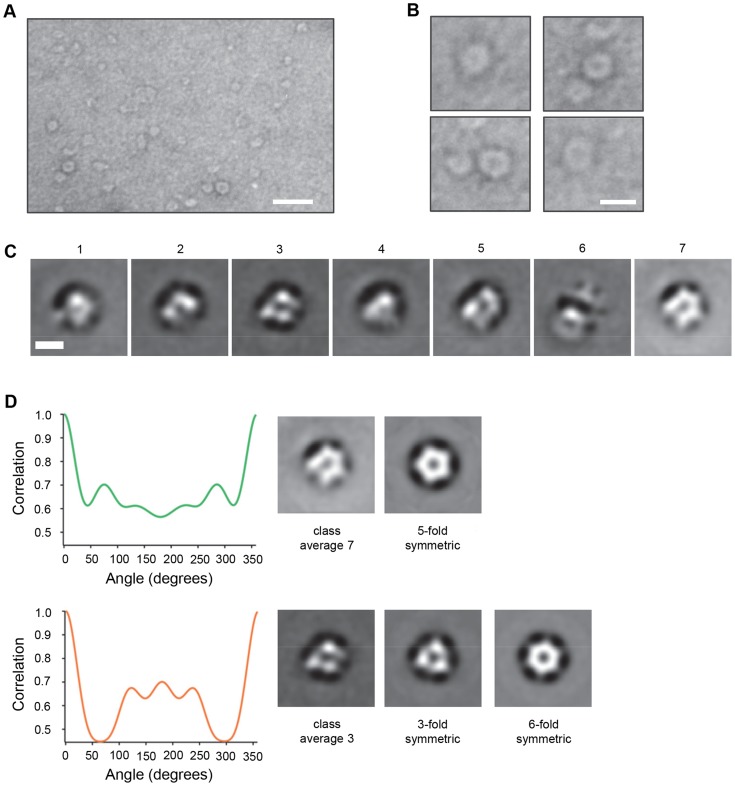
VP4 multimeric structure visualized by electron microscopy.
A. VP4GST was reconstituted in the membrane mimetic detergent DPC, applied to carbon coated grids and stained with uranyl formate. Scale bar = 20 nm. B. Individual ring-like structures were manually selected and cropped from unprocessed digital images. Scale bar = 10 nm. C. Class average images of particles automatically picked from a large image data set and classified into 7 classes. Scale bar = 5 nm. D. Class averages 3 and 7 (top-down views) analyzed by rotational harmonic analysis.